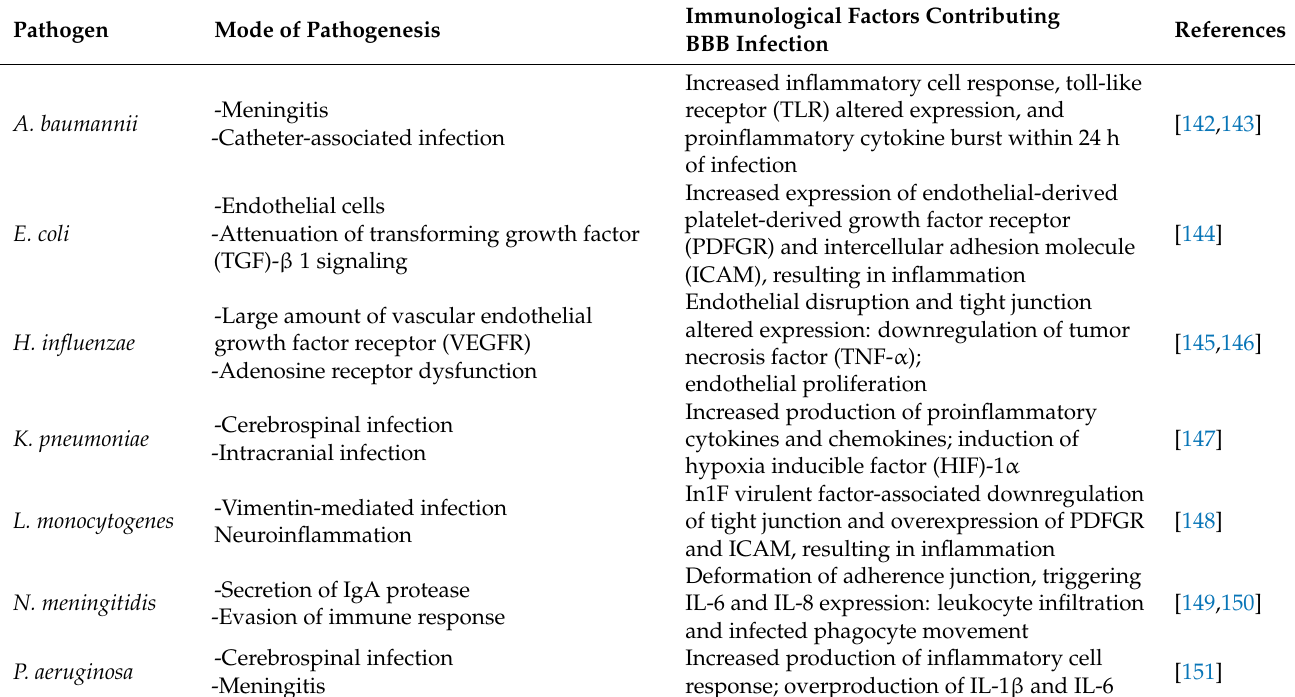
Table 5. BBB-breaching pathogenic infections and associated immunomodulatory